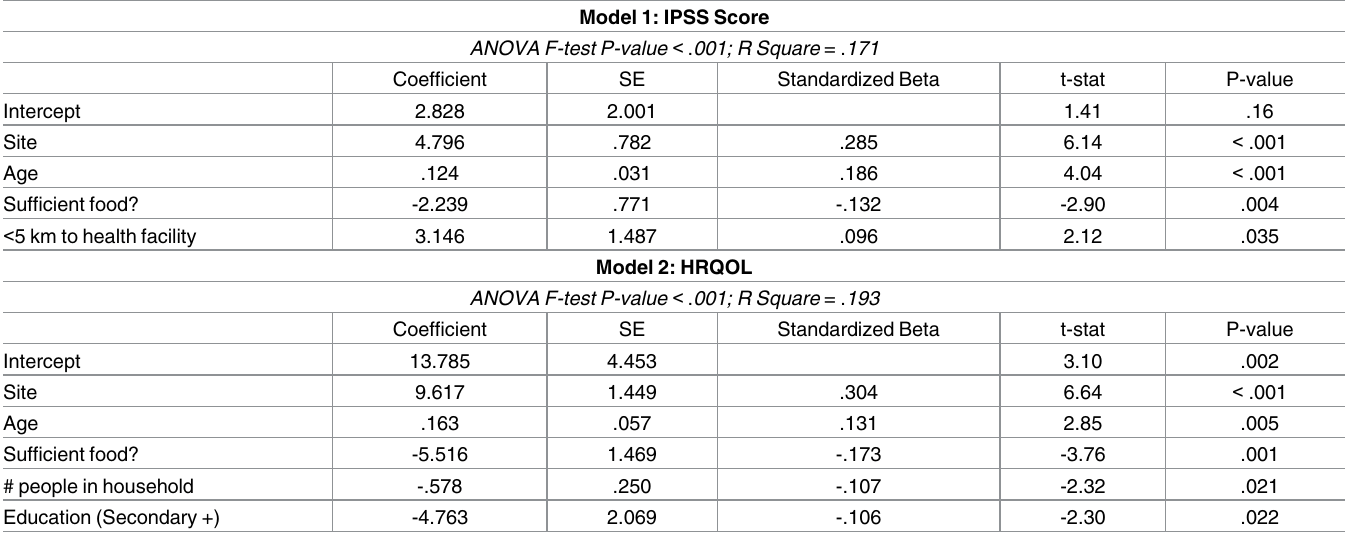
Table 5. Stepwise regression analysis of symptom scores (IPSS and